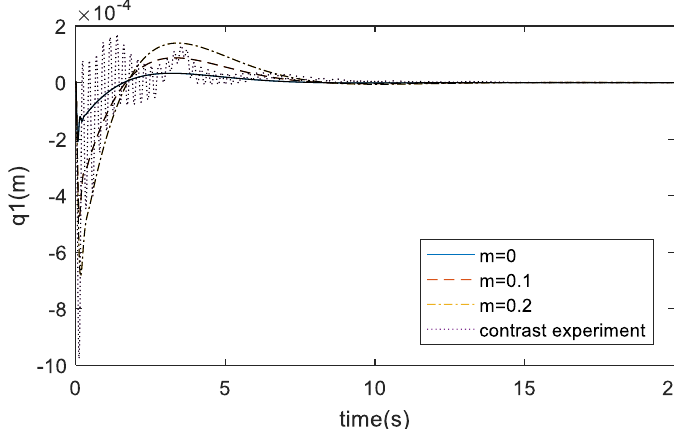
Figure 5. The position curve of flexible manipulators.